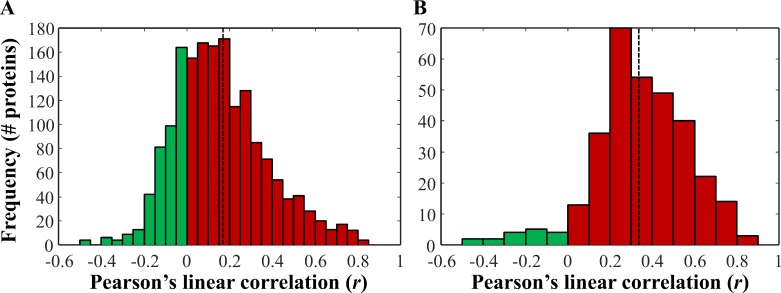
Correlation of differentially abundant proteins and respective gene expression levels in matched samples.(A) There were 725 proteins identified which had 1764 corresponding probes in the corresponding transcriptomic data. Pearson's linear correlation coefficient was used to correlate normalized spectral count levels and RMA normalized microarray data in matched samples (94 samples). The average Pearson's linear correlation coefficient (r) was 0.157 (dotted line). (B) Distribution of r for just the 344 differentially abundant proteins, of which 318 were also measured in the corresponding transcriptomic study. The average r was 0.347 (dotted line).